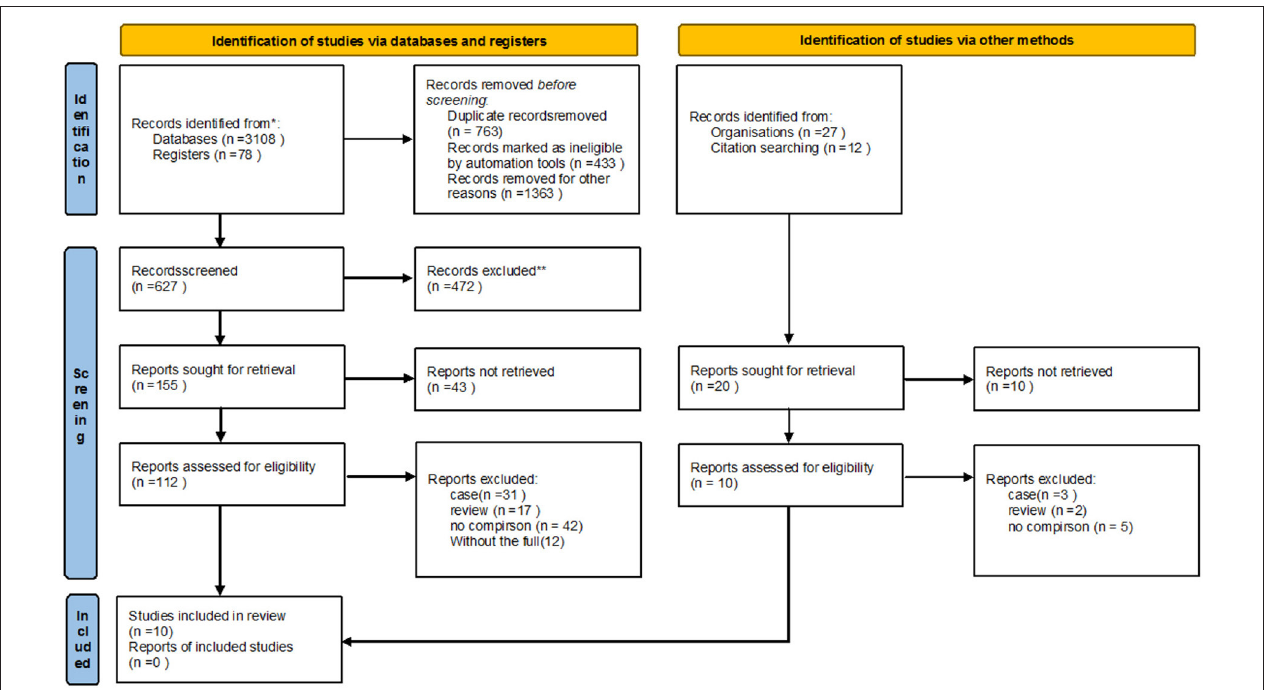
FIGURE 1 | The study identification process. *Consider, if feasible to do so, reporting the number of records identified from each database or register searched (rather than the total number across all databases/registers). **If automation tools were used, indicate how many records were excluded by a human and how many were excluded by automation